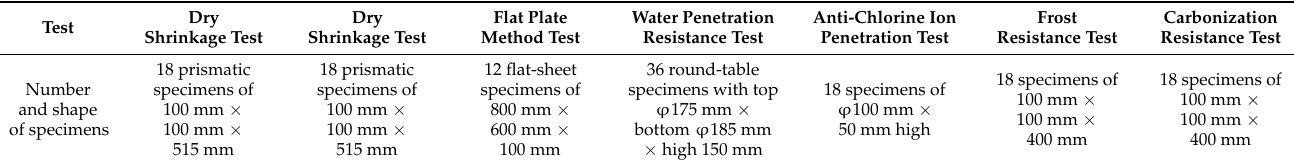
Table 2. The shape and number of experimental